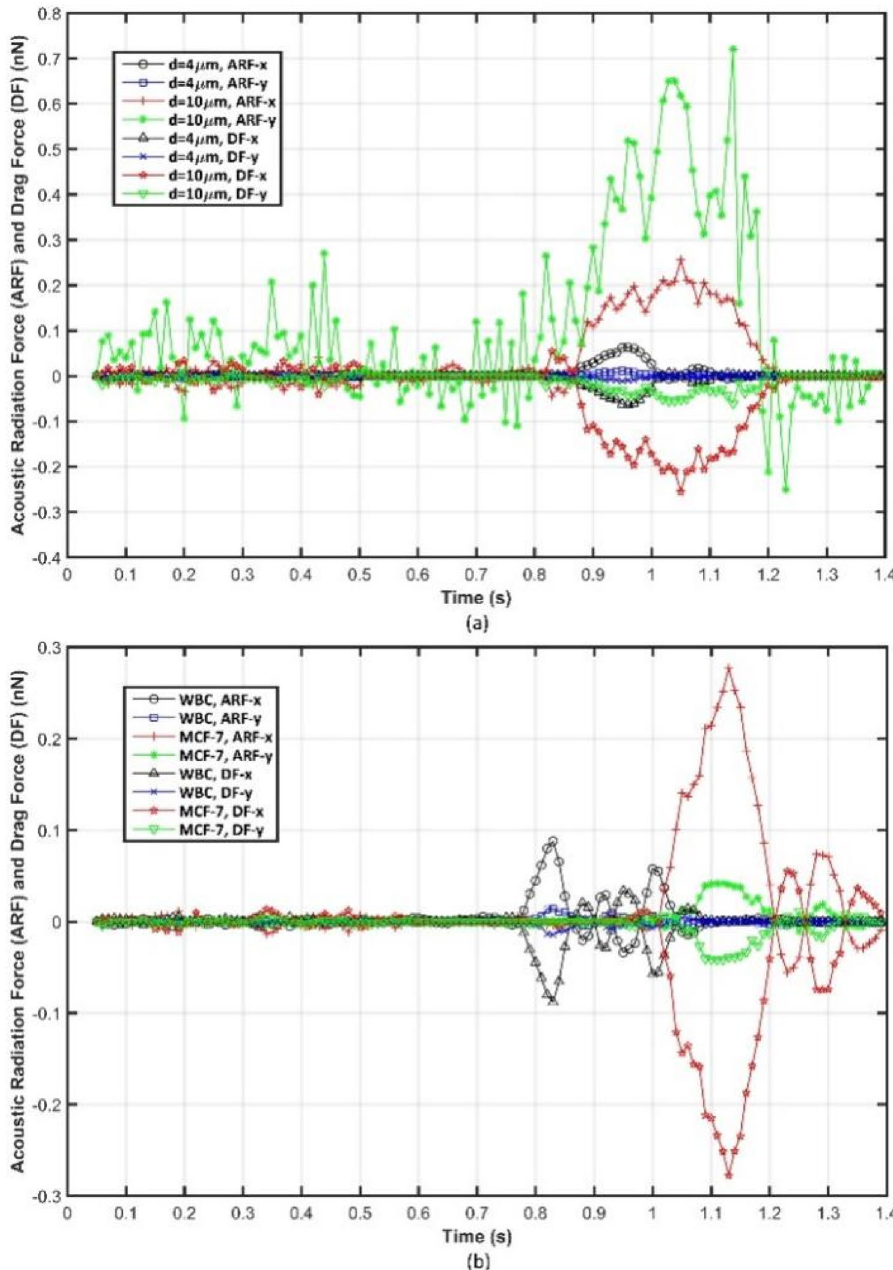
Figure 9. The applied acoustic radiation force and Stokes drag force on (a) the PS particles, and (b) WBCs and MCF-7 cancer